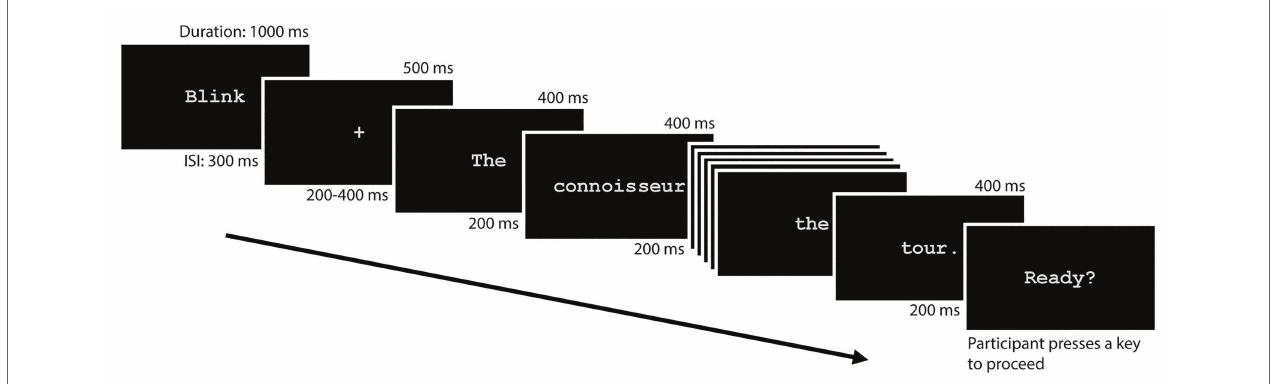
FIGURE 1 | Condensed sample trial for the current paradigm. Time values above the screen represent the duration of stimulus presentation on screen whereas time values below the screen represent the inter-stimulus interval (ISI). The “Ready?” slide requires participant input to proceed and is sometimes preceded by a comprehension question.